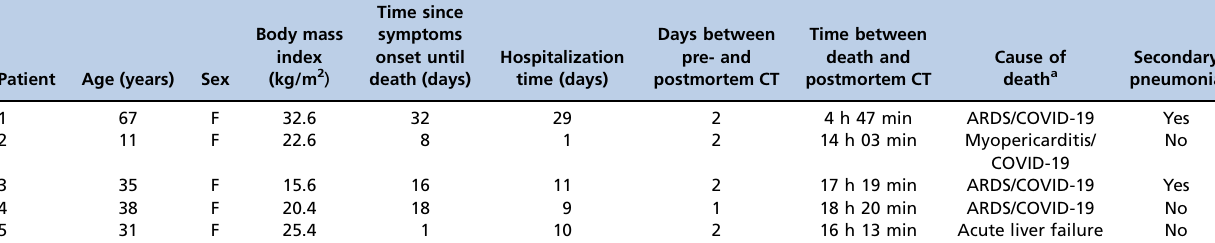
Table 1 - Main data of each